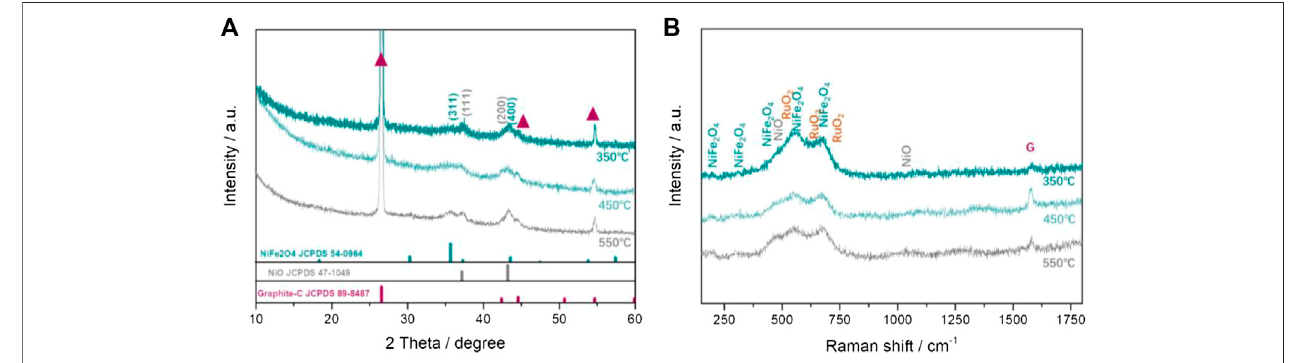
FIGURE 4 | Characterization of the NiFeRu-LDH – derived metal oxides supported on graphite foam. Typical (A) XRD and (B) Raman spectra.